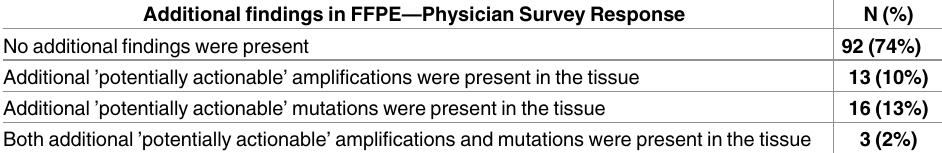
Table 2. Additional findings noted in sequencing of historic FFPE specimens compared to cfDNA sequencing. FFPE = formalin-fixed, paraffin-embeddedtissue; cfDNA = cell-free